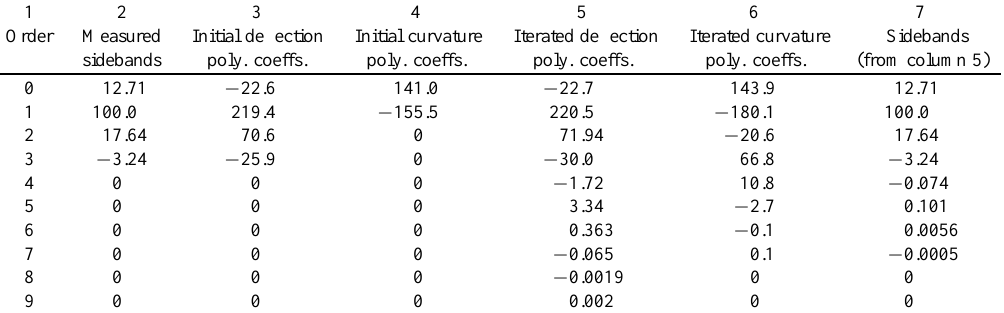
Fig. 5. Mode 3 deflected form (LHS) and curvature (RHS) for a Free-Free Beam. LDV scan A–B: Theoretical (full line), Initial measurement (dashes), Final iteration (dotted). Table 2 Half-beam scan CSLDV data, Mode